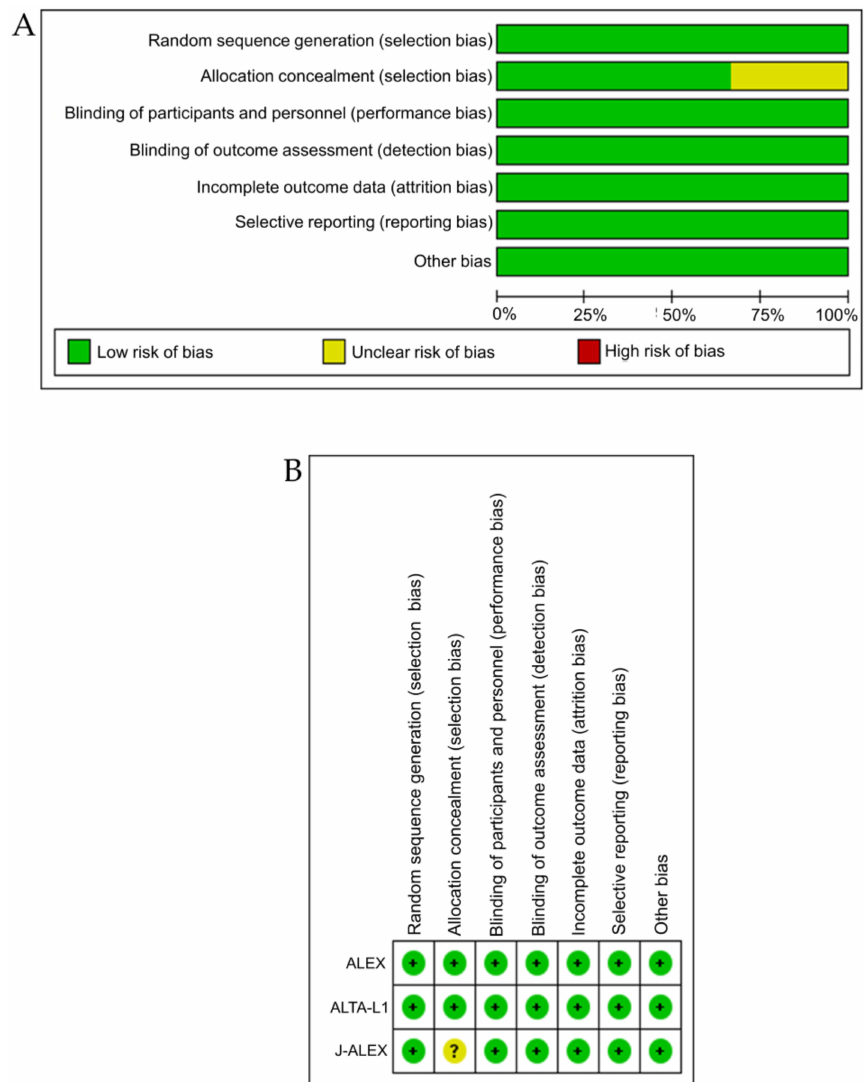
Figure 7. A risk-of-bias graph and summary. ( A ) A risk-of-bias graph: a review of authors’ judgments regarding each risk-of-bias item, presented as percentages across all included studies. ( B ) A risk-of-bias summary: a review of authors’ judgments regarding each risk-of-bias item for each included